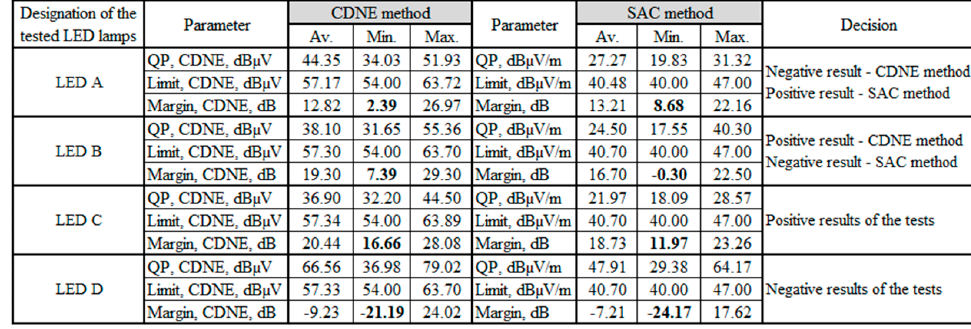
Figure 15. Summary of test results obtained using the new and traditional test methods for the tested LED lamps A ÷ D.